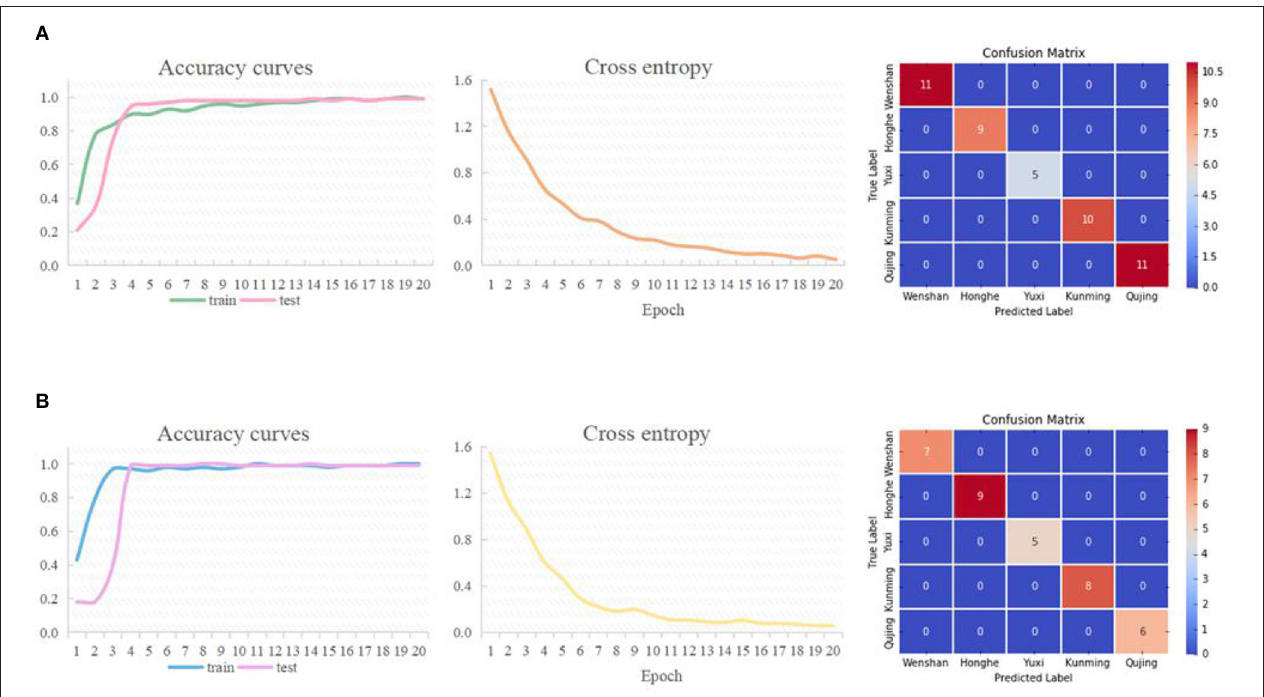
FIGURE 5 | The accuracy curves, cross entropy, and confusion matrix of ResNet models based on different spectral data. (A) FT-MIR, (B)